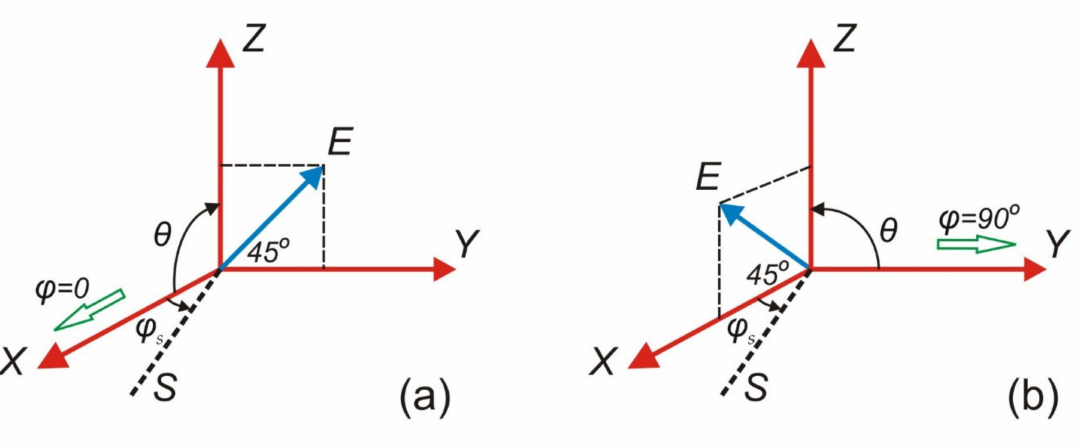
Figure 2. Orientation of KTP crystal crystallographic axes in: ( a ) X-cut KTP crystal; ( b ) Y-cut KTP crystal. Dashed line S shows the direction of second harmonic synchronism. Bold blue arrows indicate the electric vector E direction. Open green arrows show the initial waves propagation